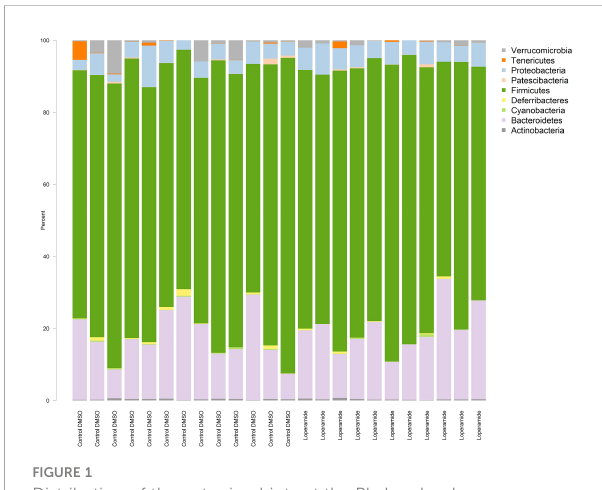
FIGURE 1 Distribution of the gut microbiota at the Phylum